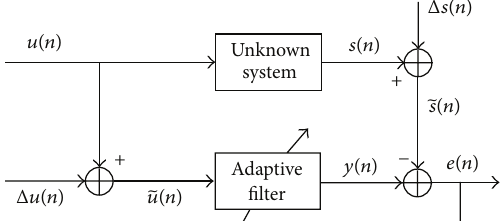
Figure 1: An unknown system identification model for adaptive filtering of noisy input